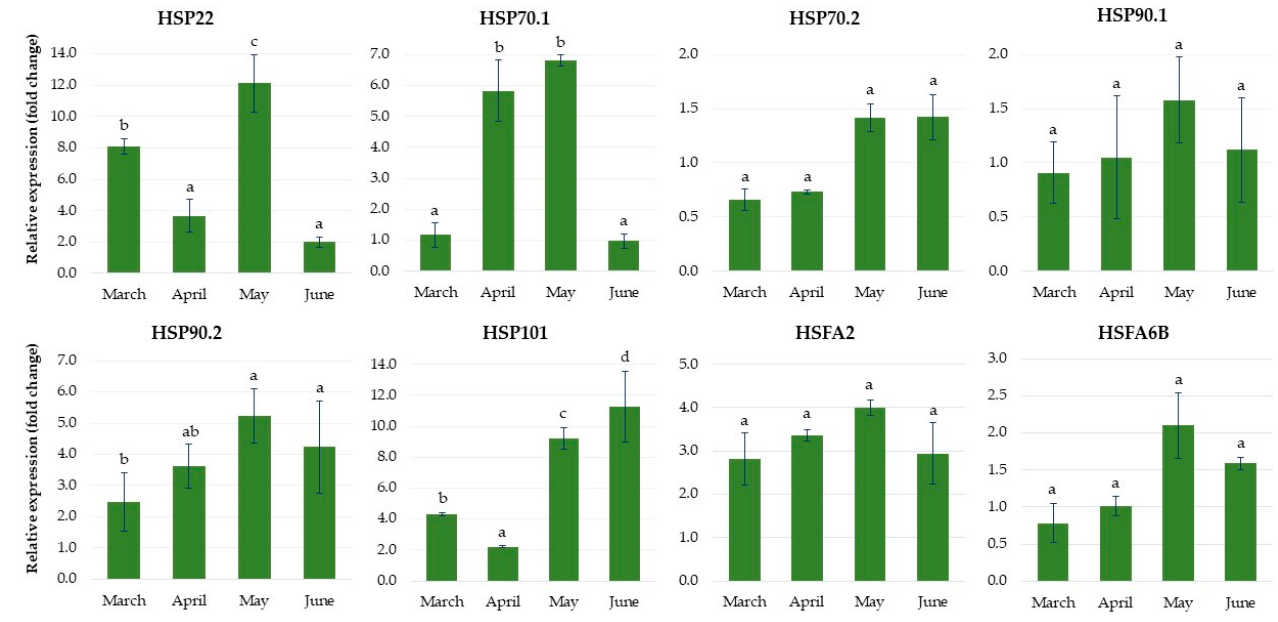
Figure 15. The relative expression of the genes encoding the heat shock proteins and heat stress transcription factors in rhubarb ‘Raspberry’ plantlets during ex vitro growth in the greenhouse from early March to the end of June. According to Duncan’s test ( p = 0.05), means marked with the same letter do not differ significantly ( p = 0.05). Error bars represent standard deviation.